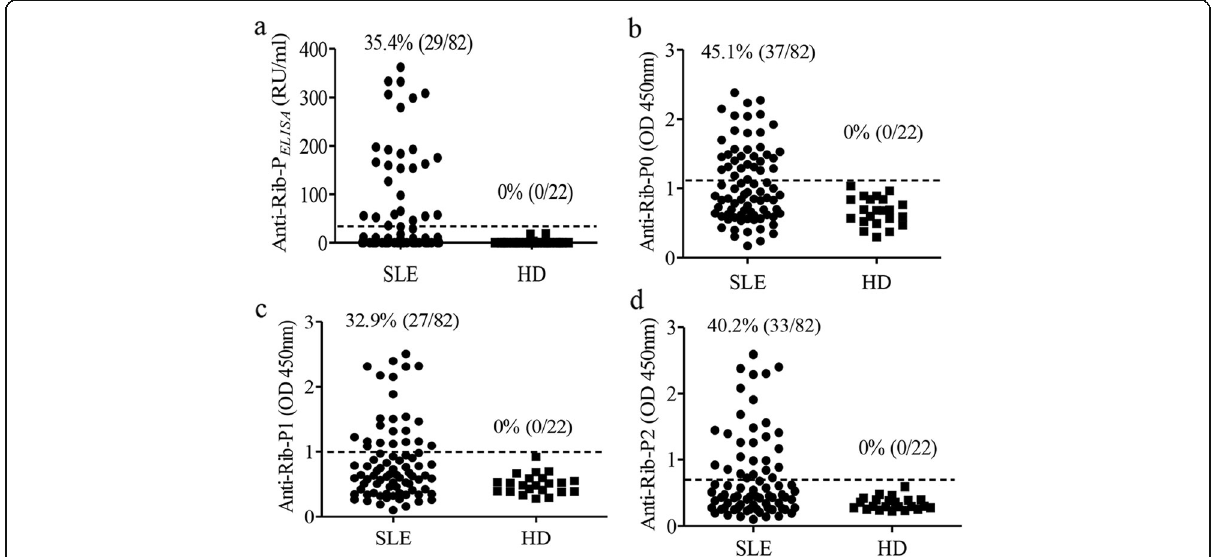
Fig. 1 Serum levels of autoantibodies against ribosomal proteins in SLE and healthy donors. Autoantibodies directly against native ribosomal P heterocomplex (Rib-P ELISA ) ( a ), recombinant ribosomal P0 protein (Rib-P0) ( b ), recombinant ribosomal P1 (Rib-P2) ( c ) and recombinant ribosomal P2 protein (Rib-P2) ( d ) were measured by enzyme-linked immunosorbent assay. Dotted lines represent the distinct cut-offs based on ROC curve analysis at the specificities of 99%. The prevalence of antibodies are indicated in percentage for each cohort. Numbers in brackets represent serum positive and total cases, respectively. Data represent at least three independent